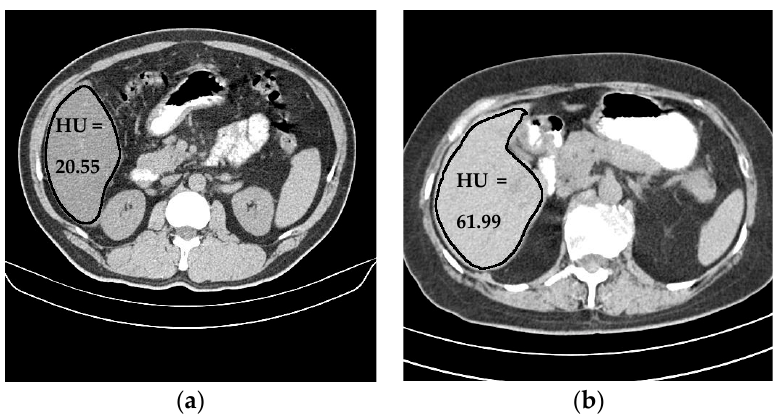
( b ) Figure 12. Two samples show the area where the CT slices are selected from. ( a ) Front view, ( b ) side